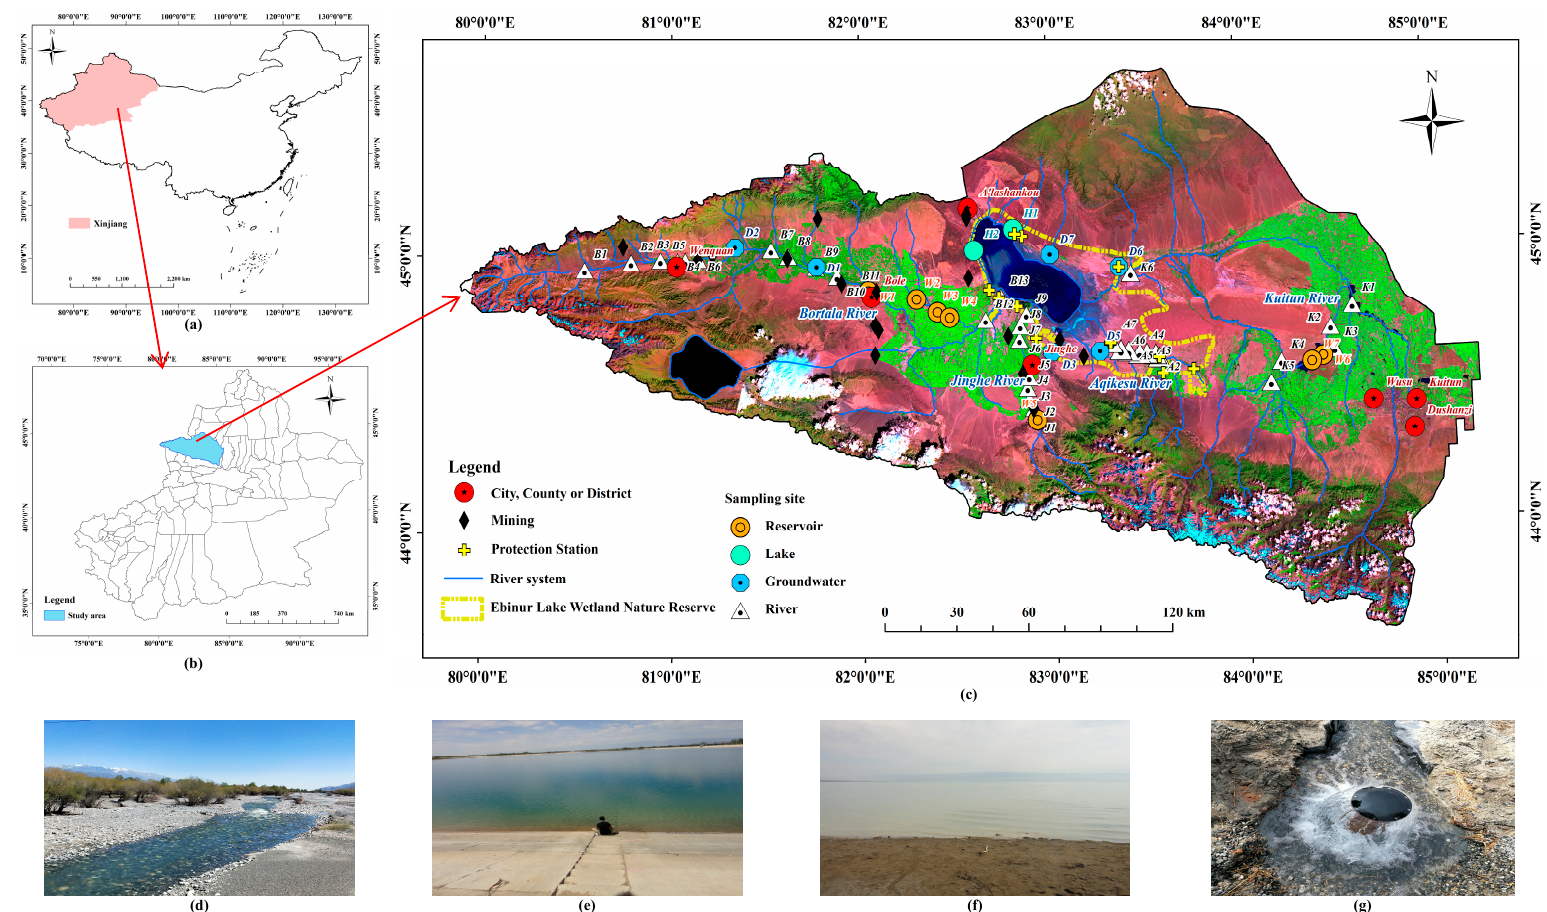
Figure 1. ( a ) The location of the Xinjiang Autonomous Region in China; ( b ) A map of the study area; ( c ) A satellite map of the study area; ( d ) river water (sample site B1), ( e ) reservoir water (sample site W4), ( f ) lake water (sample site H2), and ( g ) groundwater (sample site D7) (photographed ( d – g ) by Shidan Zhu; (map of ( a – c ) by ArcGIS10.2.2 (http://www.esri.com/software/arcgis)).